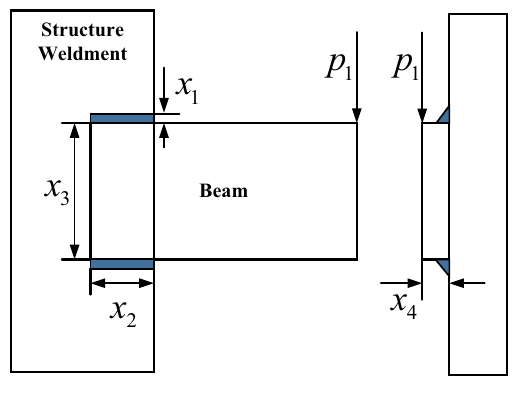
Fig. 9 The welded beam